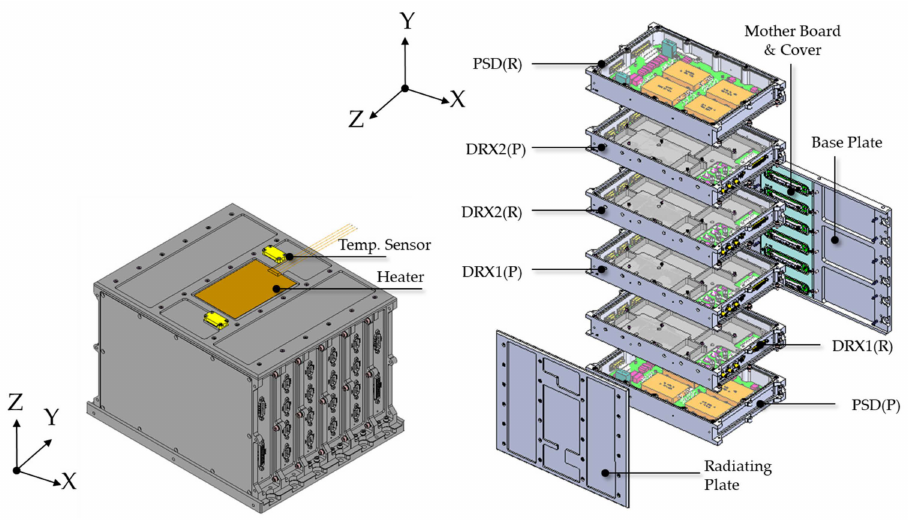
Figure 3. Mechanical configuration and exploded view of